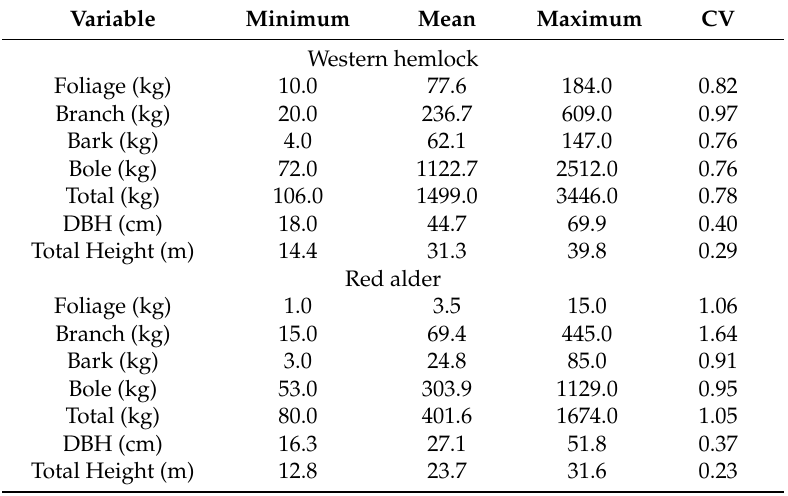
Table 1. Summary statistics of tree data used in this study. CV is the coefficient of